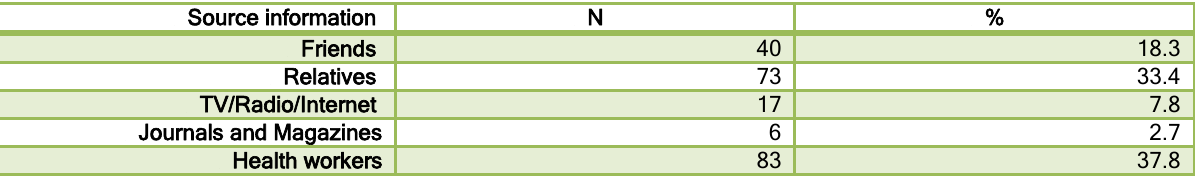
Table 2 : The distribution of the studied sample according to the source of information (N=219) .